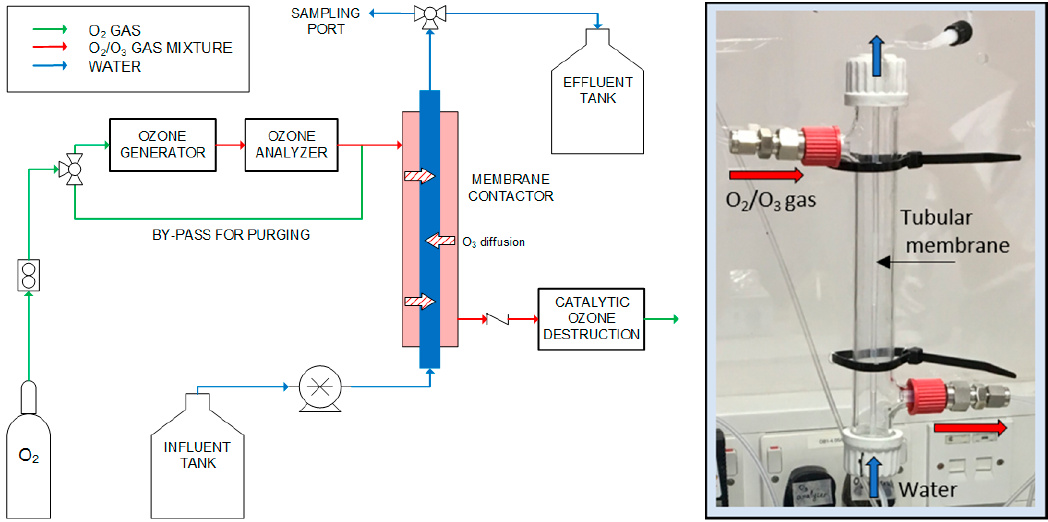
Figure 1. Schematic of the experimental setup and photograph of the membrane contactor.